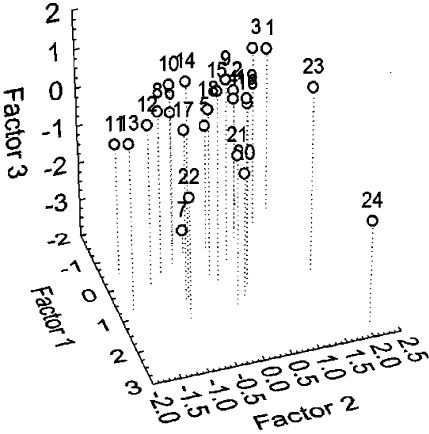
Fig. 3 Principal component analysis ordination (3D) of physical and chemical parameters of Korangi creek sediment